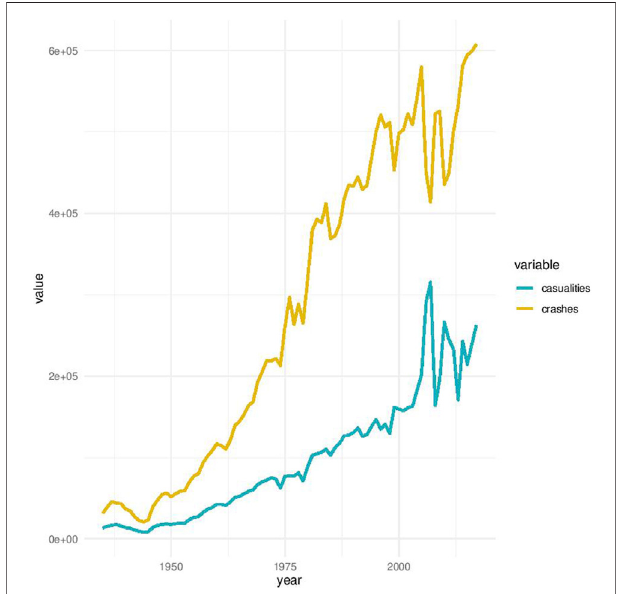
FIGURE 2 | Trends in number of crashes (road crashes) and casualties over the period 1935 – 2017 covered in this study.